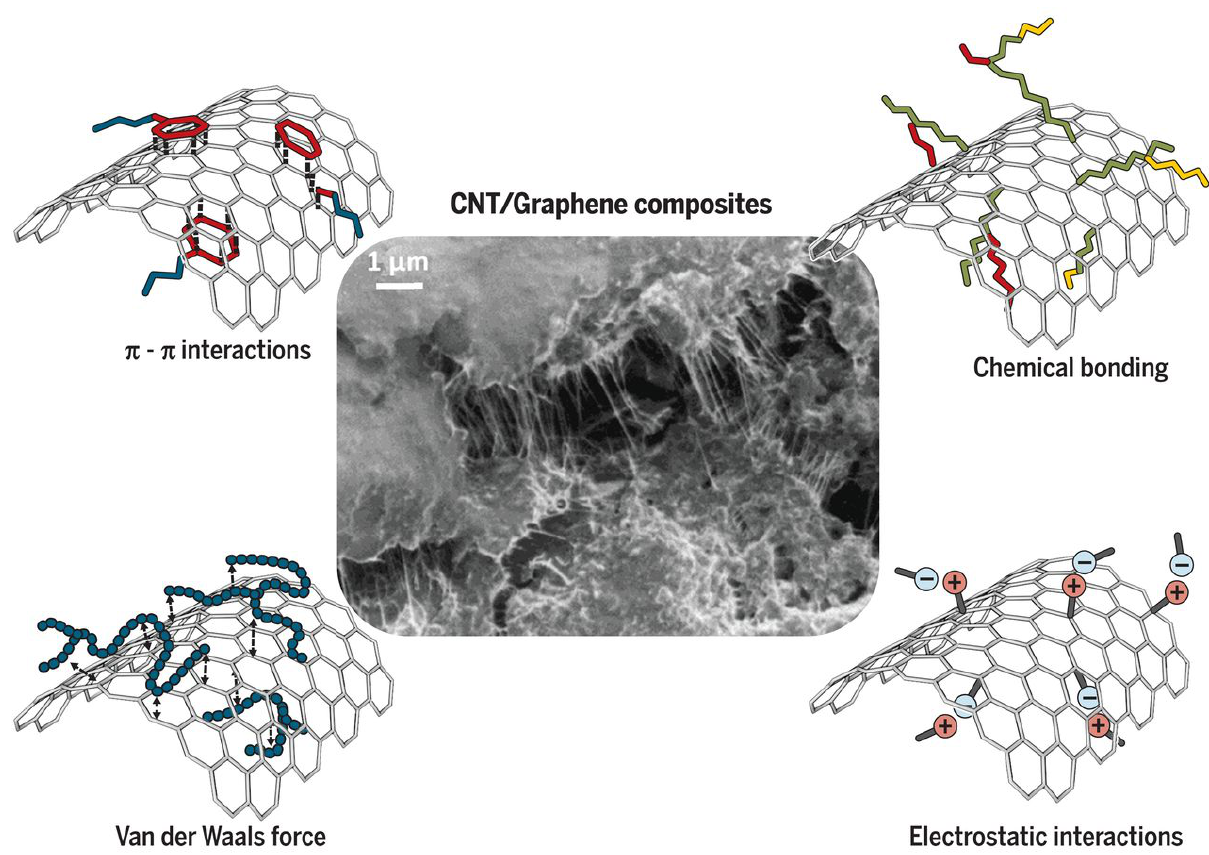
Figure 1: Schematic diagrams of four different chemical modification schemes of the interaction of CNTs or graphene with a polymer ma- trix